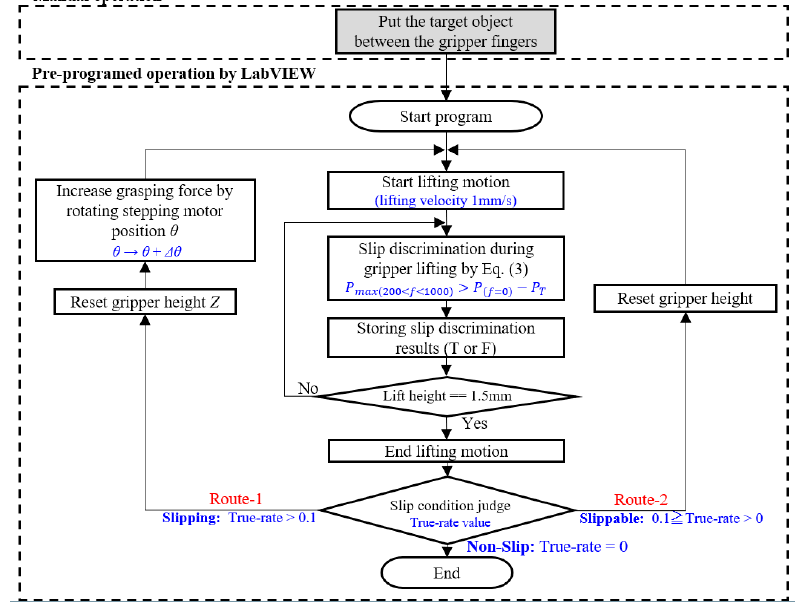
Figure 9. Sequence of grasping force control with the μ -LDV signal.